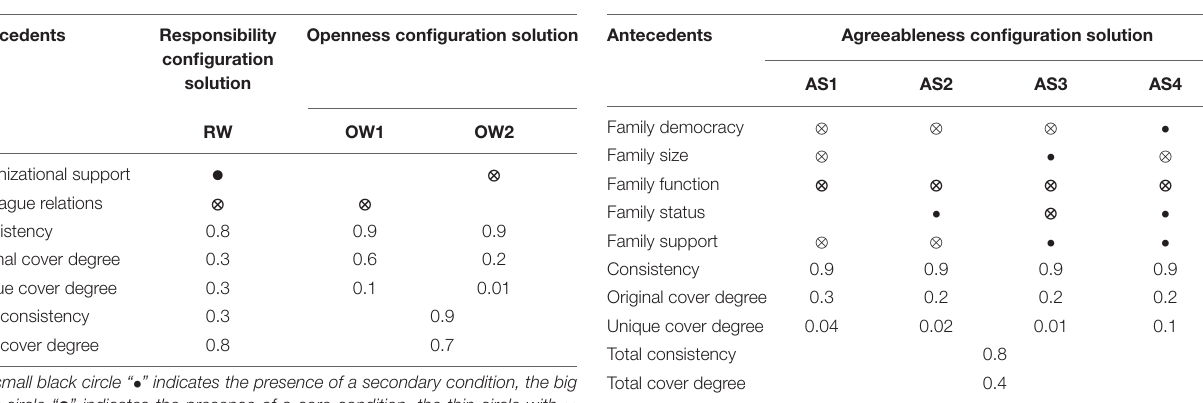
TABLE 8 | Matching analysis between family experience and non-high original innovation